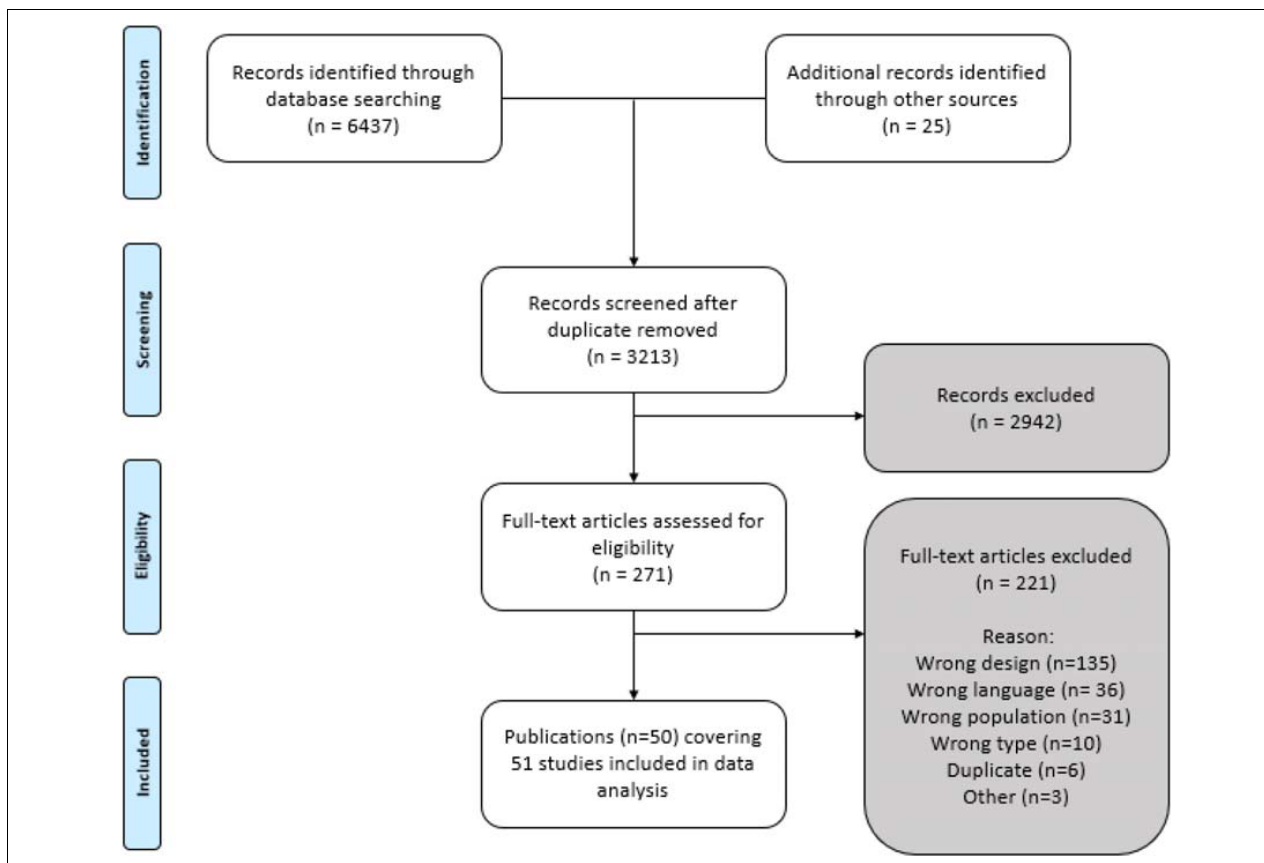
FIGURE 1 | Study selection flowchart modified from Moher et al.